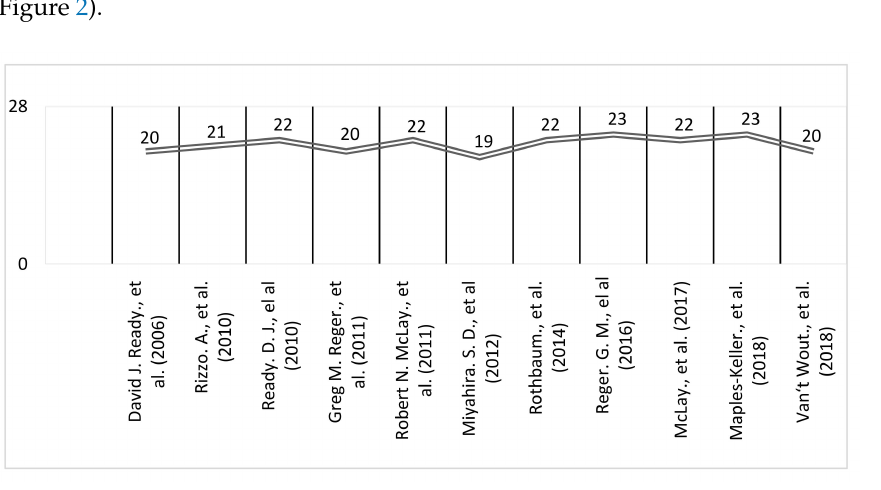
Figure 2. Downs and Black (1998) [33]—Checklist for assessment of the methodological quality